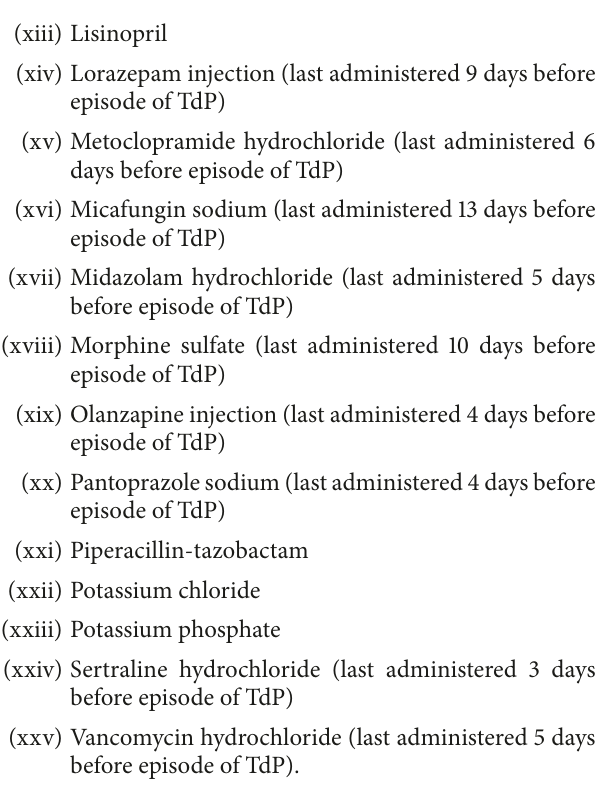
Figure 3: Torsades de Pointes (Day